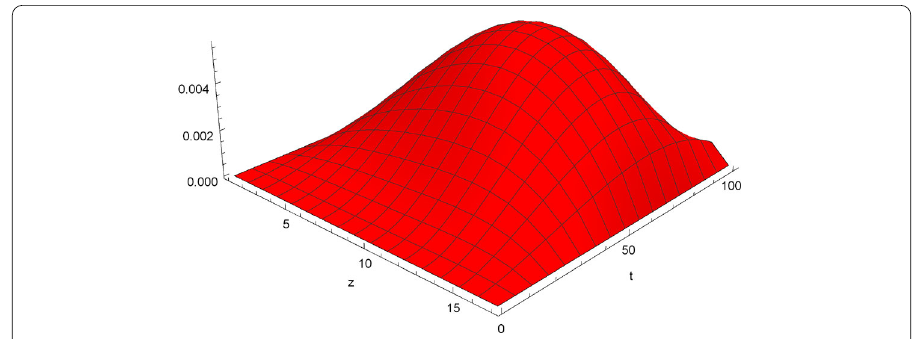
Figure 6 Absolute error graph for Example 2 at t = 1 when N = 16, α = 1.5 and 0 ≤ z ≤ 1